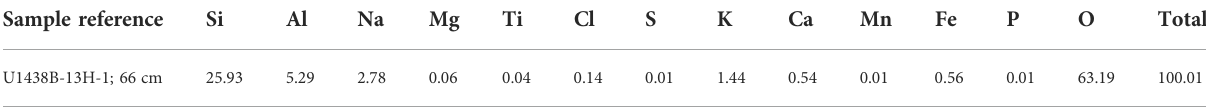
TABLE 2 Electron microprobe analytical data obtained at Oregon State University for the volcanic ash sample collected at 111.9 mbsf, at IODP Site U1438. The full sample reference is U1438B-13H-1; 66 cm. The data is given in molar ratios of each chemical element. This dataset is used to de fi ne the chemical composition of the volcanic ash implemented in the numerical model developed with